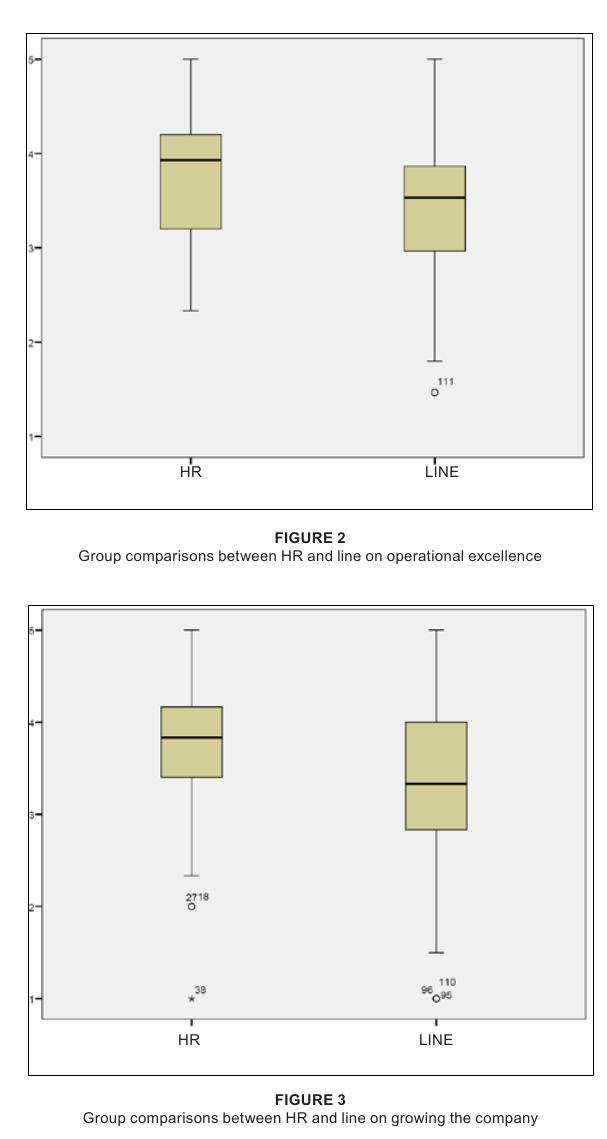
FIGURE 3 Group comparisons between HR and line on growing the company